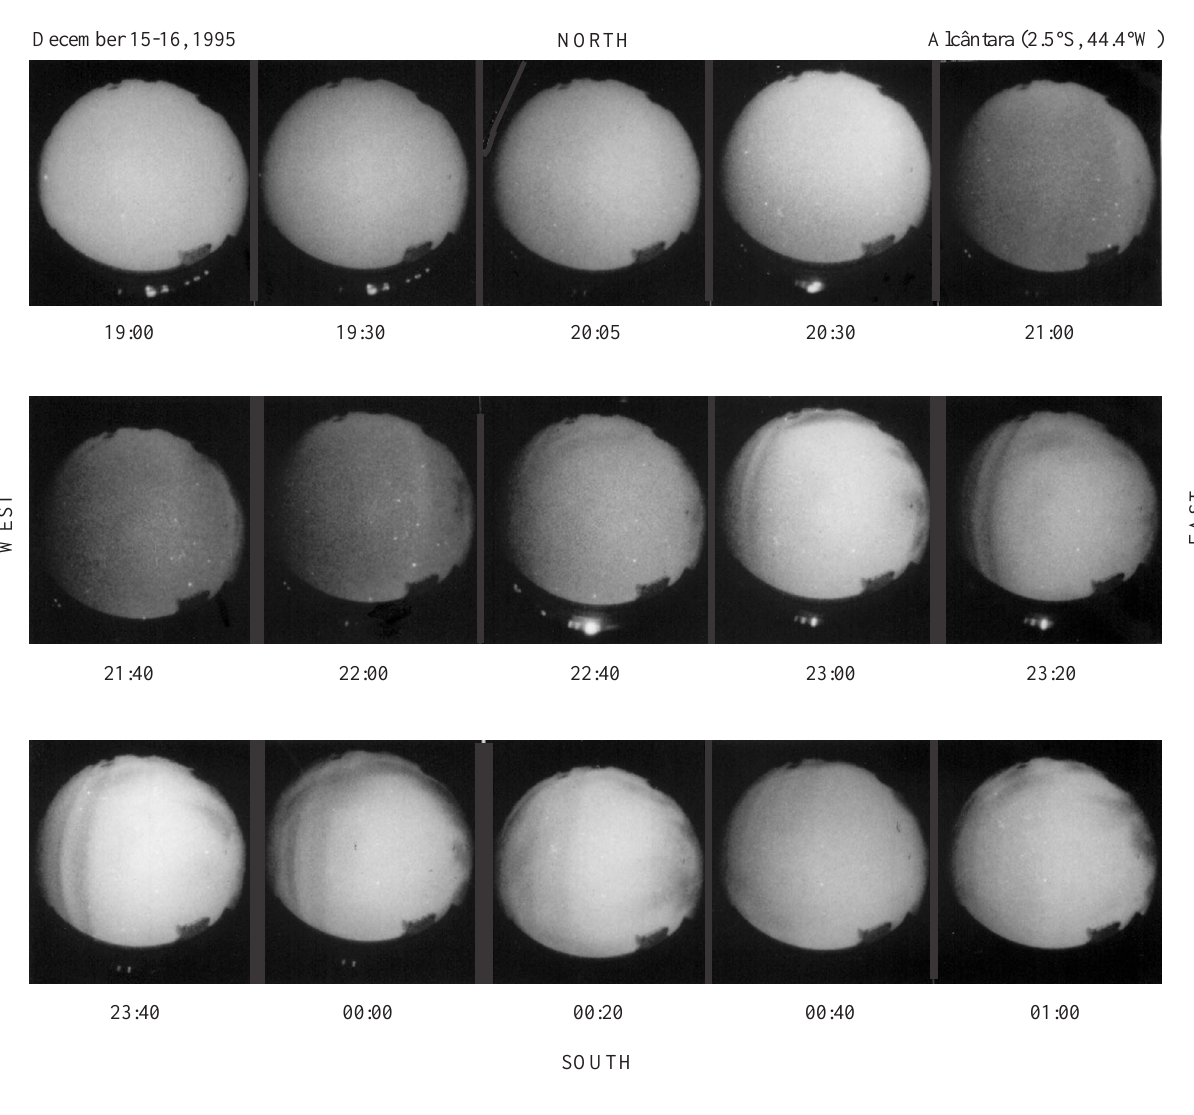
Fig. 3. Same as Fig. 3, but for December